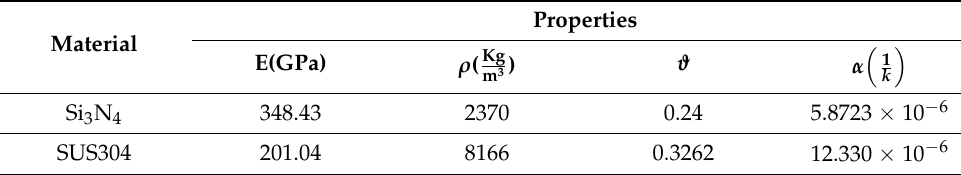
Table 1. Material properties of the FGM layers [18].